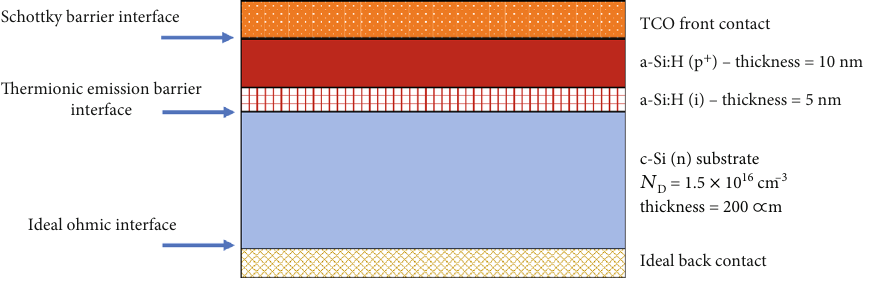
Figure 1: Structure of the modeled SHJ device. Table 1: Parameter values used in the simulation of the SHJ devices under study.